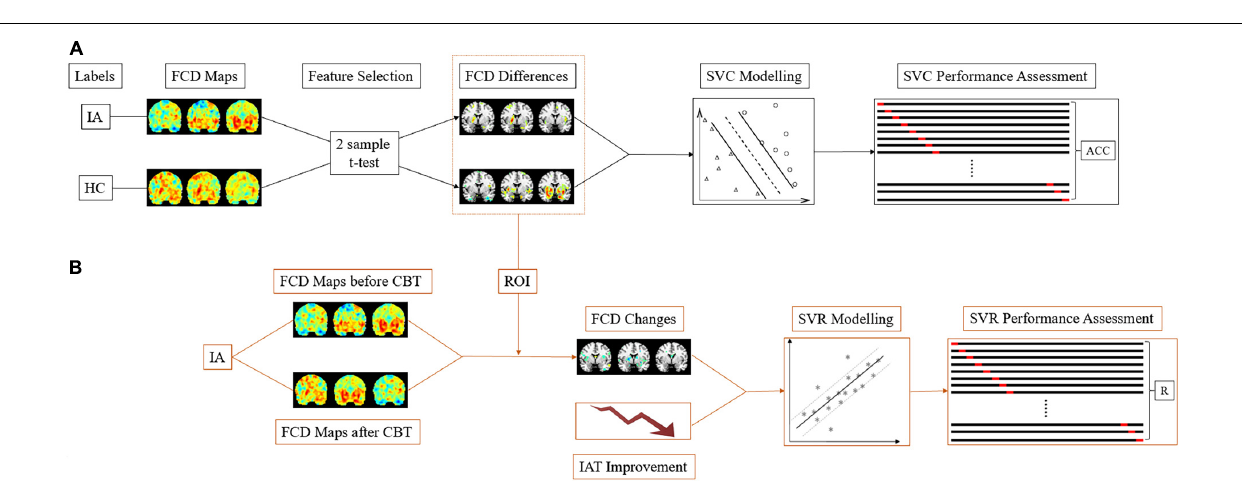
FIGURE 2 | The SVM schematic flow. (A) In the SVC model, the gFCD, lFCD, and lrFCD differences between the HC and IA groups (pretreatment) were used as features for pattern identification. Leave-one-out cross-validation was applied to performance assessment. (B) In the SVR model, the alterations of discriminative gFCD, lFCD, and lrFCD were used as features to predict the improvement of IAT. The performance of the SVR model was represented by the correlation of actual IAT scores to predict IAT scores collected in each leave-one-out-cross-validation fold. IA, internet addiction; HC, heathy control; SVC, support vector classification;